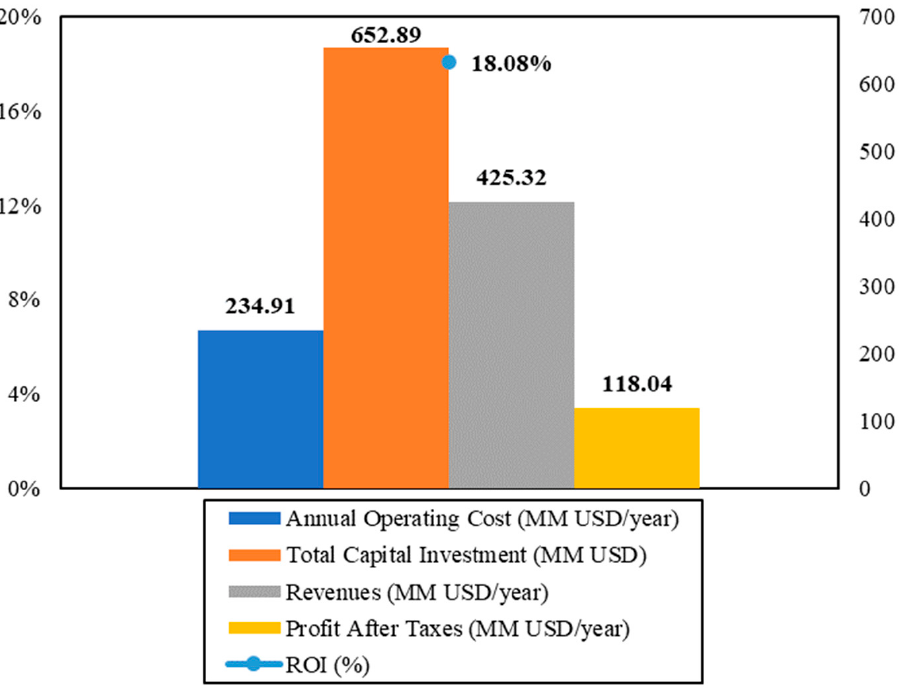
Figure 6. Summary of Economic Evaluation Results for the chitosan production from shrimp exoskeleton. Adapted from: [14].